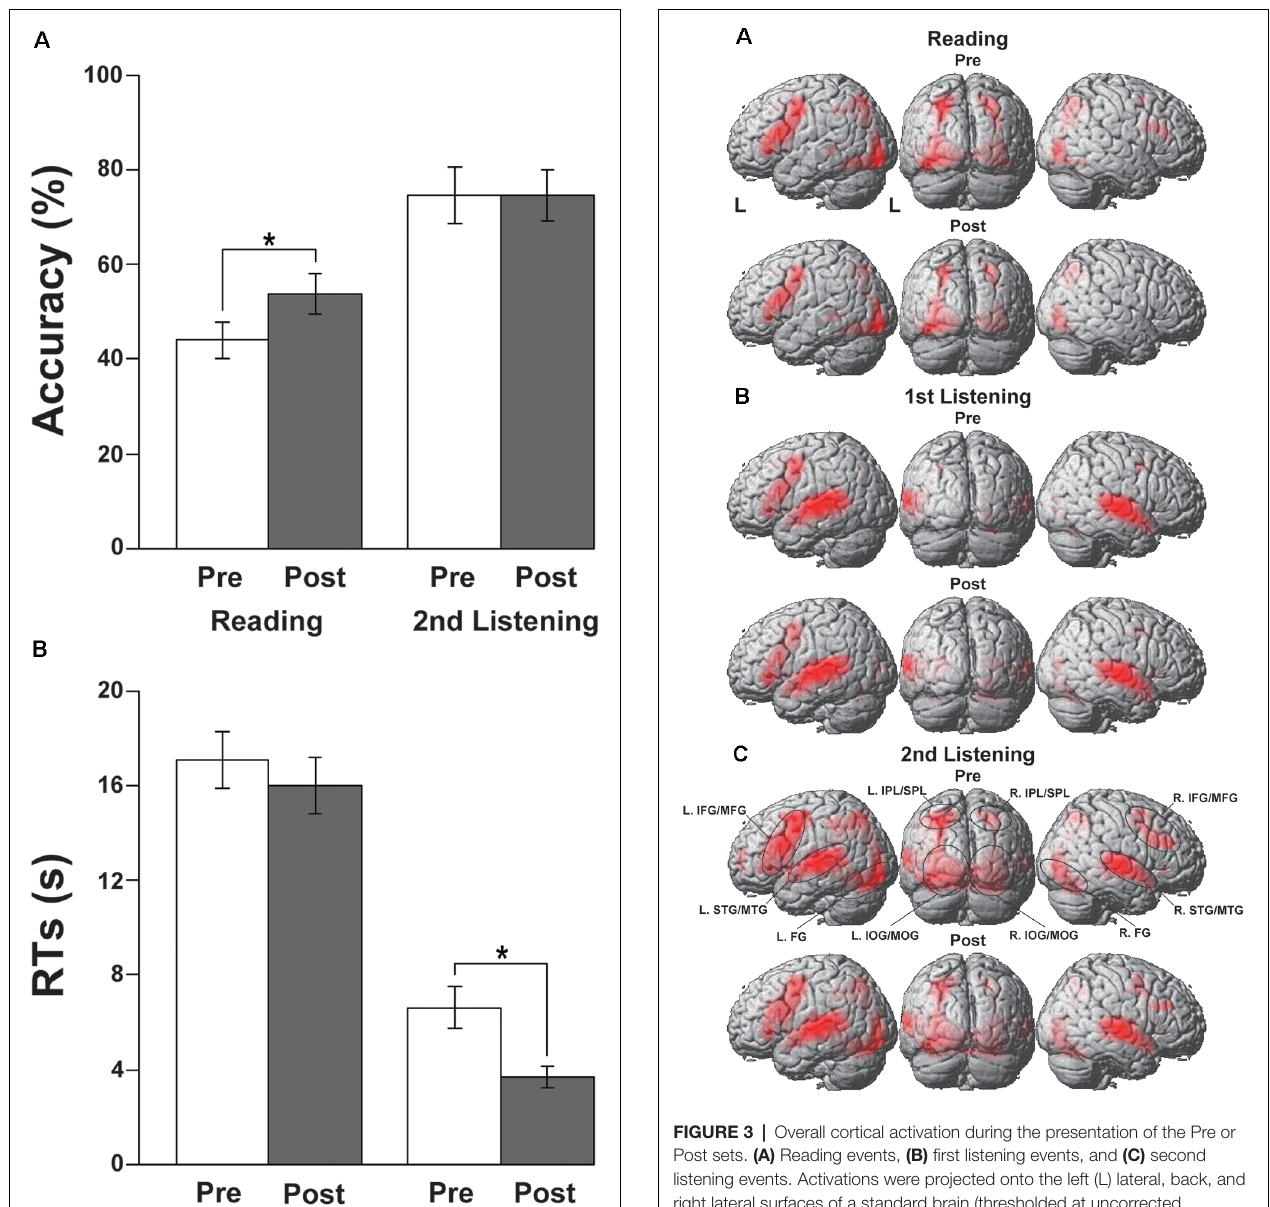
second listening events. During the reading events ( Figure 3A ), IFG/MFG, as well as in the bilateral IPL/SPL, FG, and IOG/MOG,